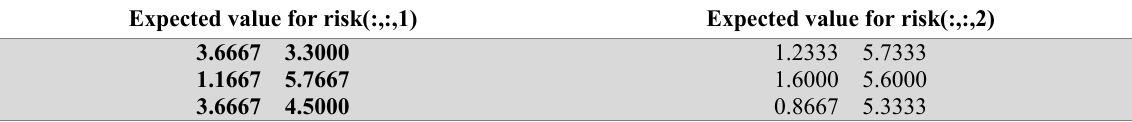
Expected Value for Risks